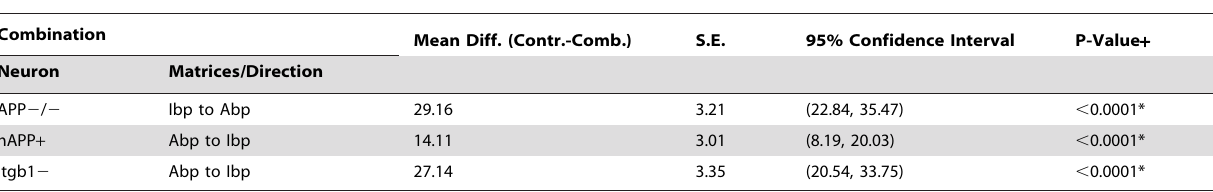
Table 10. Haptotactic Assays. Statistical Analysis.